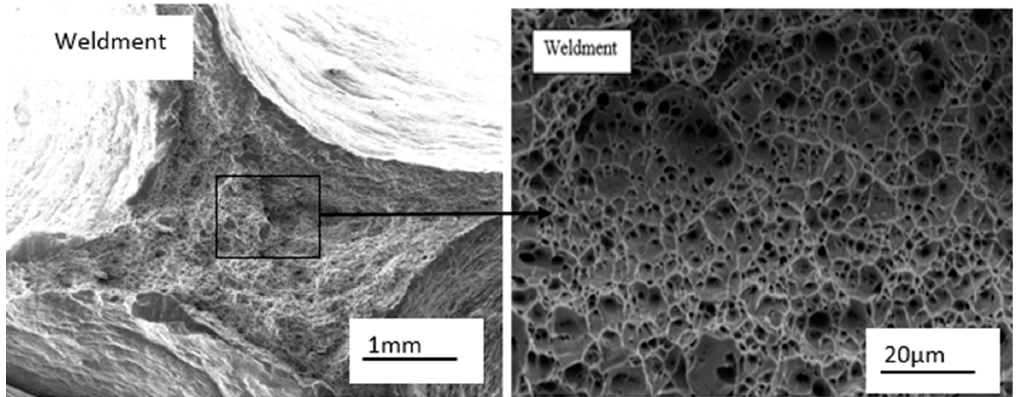
Figure 17. Micrograph of the welded specimen.